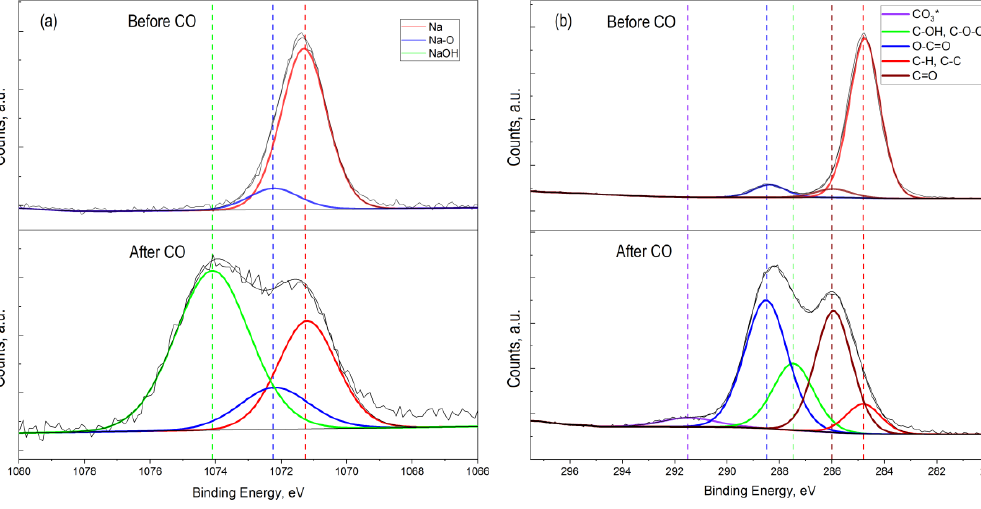
Figure 7. High-resolution XPS spectrum of Na 1s ( a ) and C 1s ( b ) 2p for ZTO film with Zn:Sn ratio = Figure 7 95:5 before and after CO treatment at T = 300 ◦